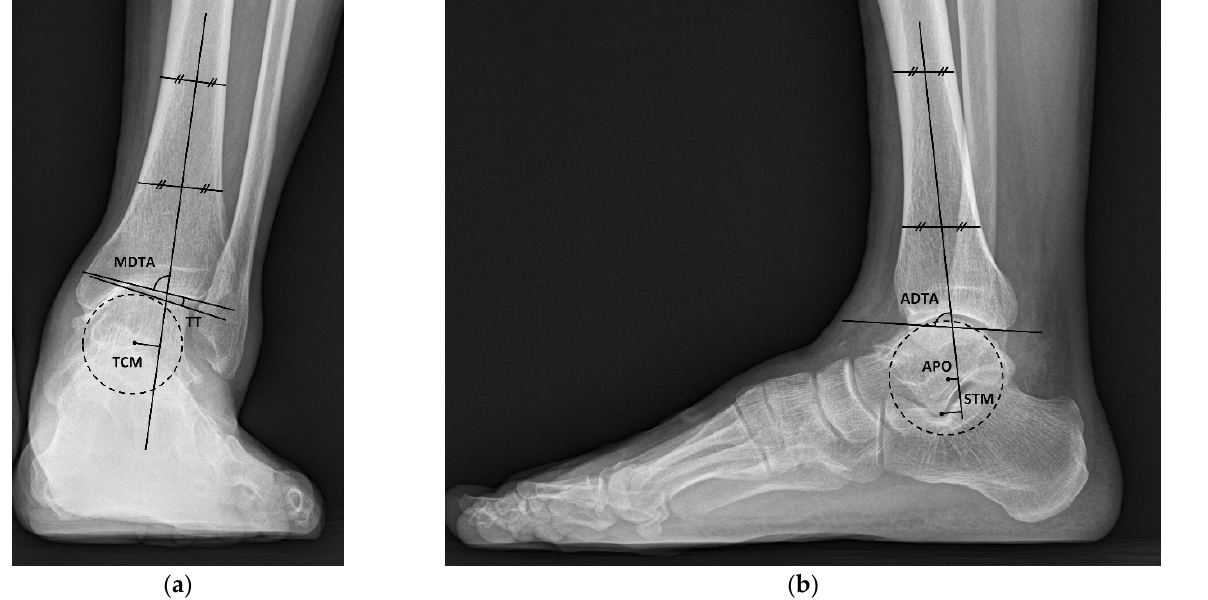
Figure 1. ( a ) Weightbearing ankle anteroposterior radiograph shows measurement of the medial distal tibial ankle (MDTA), the talar tilt (TT), and the talus center migration (TCM). ( b ) Weightbearing foot lateral radiograph shows measurement of the anterior distal tibial angle (ADTA), the anteroposterior offset (APO), and the sagittal talar migration (STM).